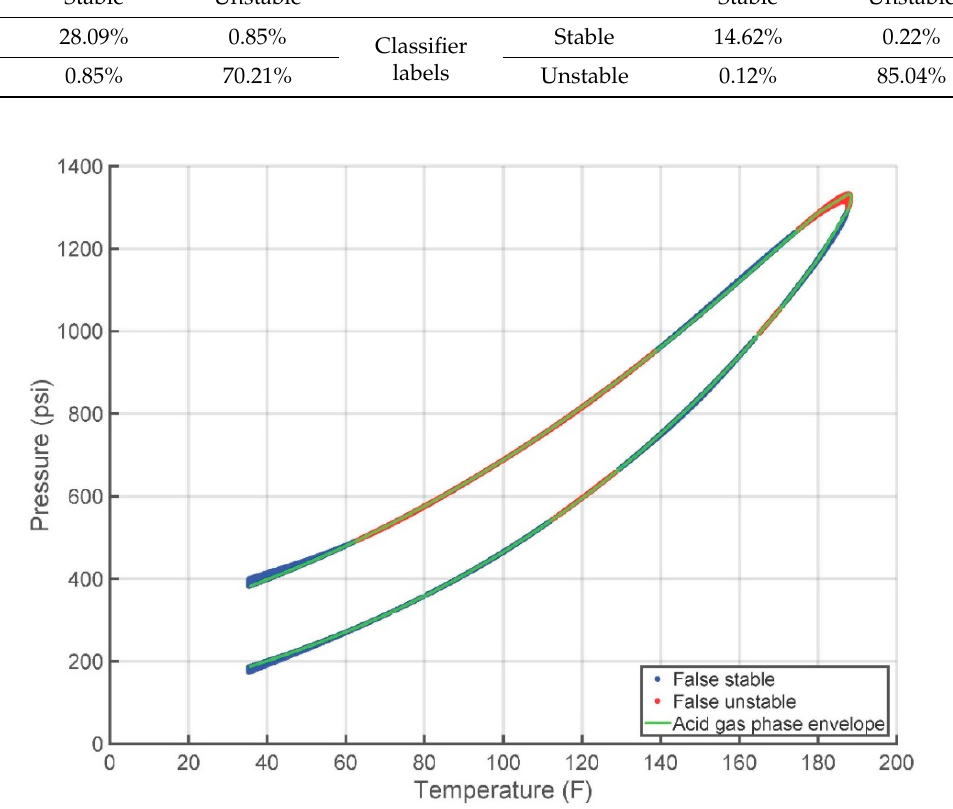
Figure 8. Visualization of the neural network model results on testing datapoints (86% H 2 S).